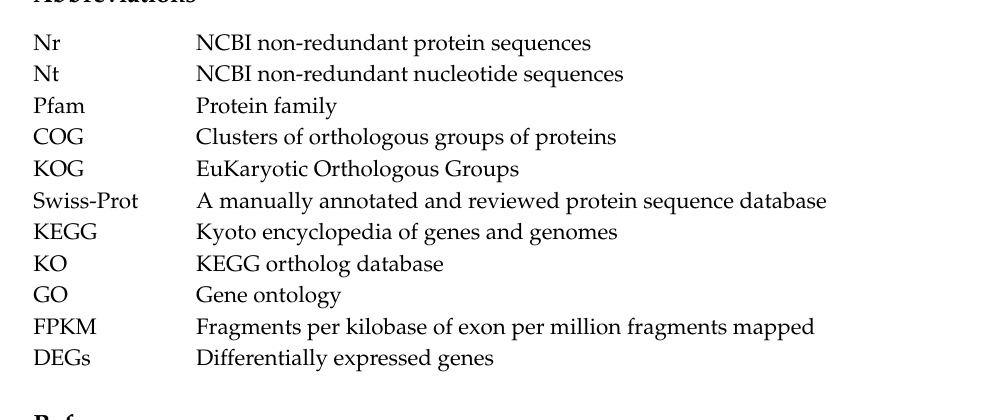
Table S1: Primer sequences; Figure S1: KEGG pathway enrichment of up-regulated and down-regulated DEGs; Figure S2: Comparison of expression results between RNA sequencing (RNA-seq) and qRT-PCR; Figure S3: Heatmap of important DEGs associated with cold-tolerance; Figure S4: Heatmap of differentially expressed transcription factors (TFs) associated with